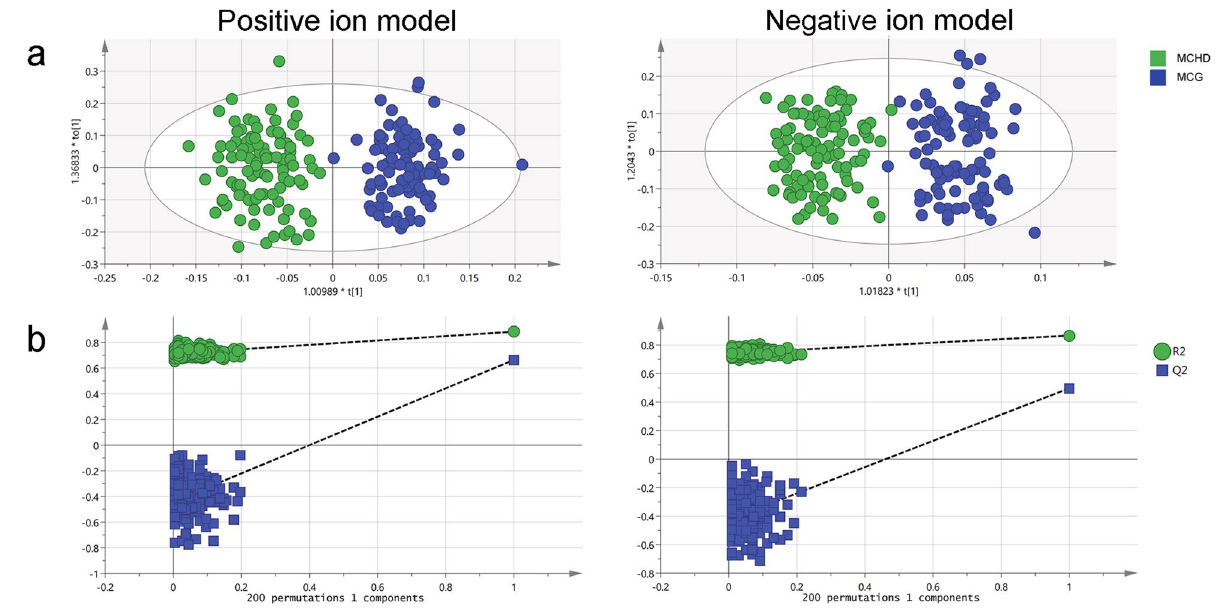
Figure 3. Alteration of metabolites between mothers of infants with CHD and controls. ( a ) OPLS-DA of plasma samples from mothers of infants with CHD and controls under positive and negative ion mode (positive ion model: R2X(cum) = 0.248, R2Y(cum) = 0.977, Q2(cum) = 0.752; negative ion model: R2X(cum) = 0.234, R2Y(cum) = 0.949, Q2(cum) = 0.683). ( b ) Validation of OPLS-DA model under positive and negative ion mode